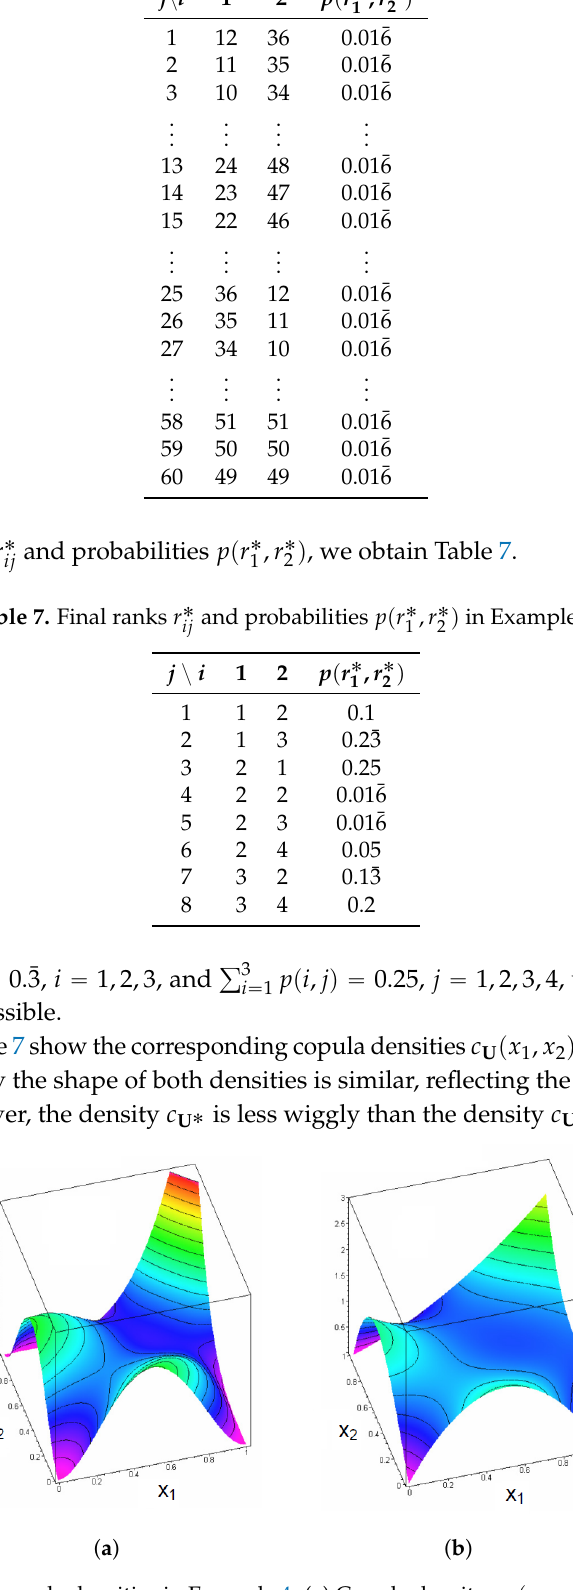
Figure 7. Plots of the copula densities in Example 4. ( a ) Copula density c U c U ˚ x 1 , x 2 p q